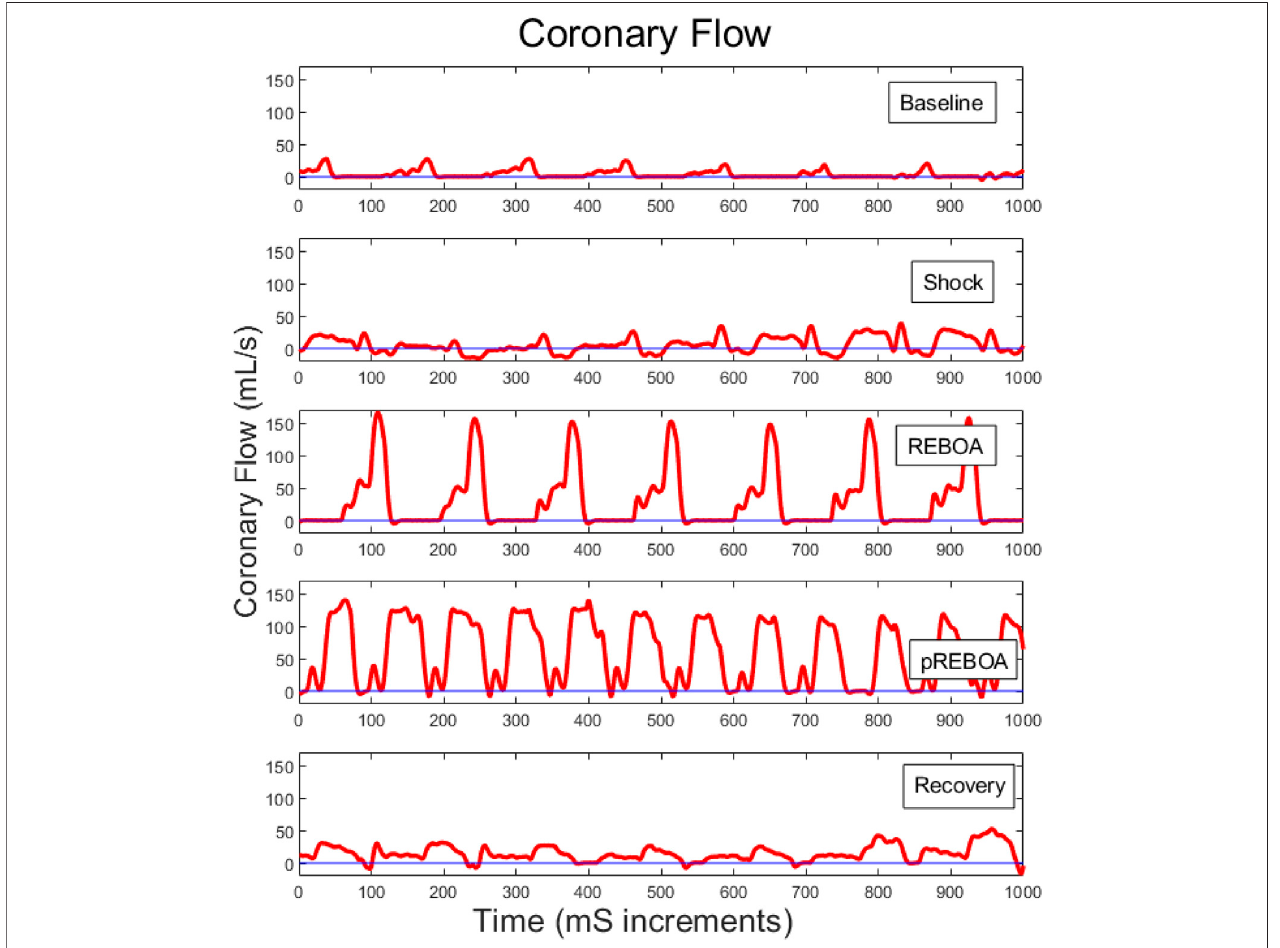
FIGURE 6 | Representative left coronary fl ow waveforms for one study animal across each of the study periods. Baseline coronary fl ow wave forms evolve during shock to include a larger percent of each cardiac cycle in retrograde fl ow. REBOA then rescues this fl ow reversal but causes substantially higher peak coronary fl ows. Partial REBOA (pREBOA) has slightly lower peak fl ows compared to REBOA, but these remain higher than Shock or Baseline, with still little fl ow reversal. Transition to Recovery period is associated with normalization of coronary fl ow waveforms.